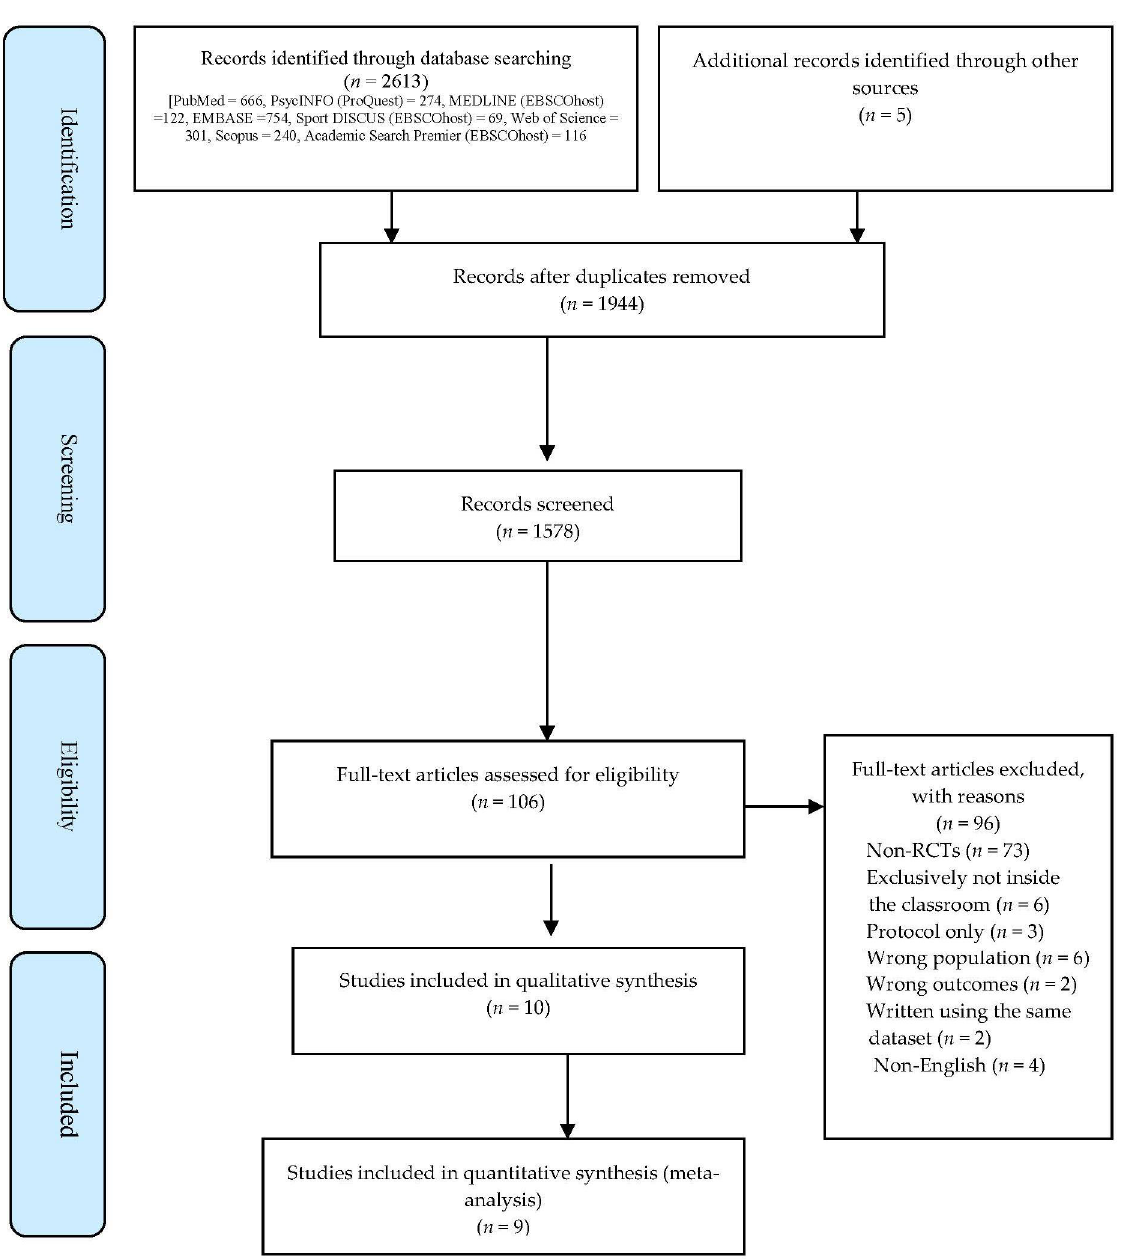
Figure 1. PRIMA Flowchart for selecting studies.